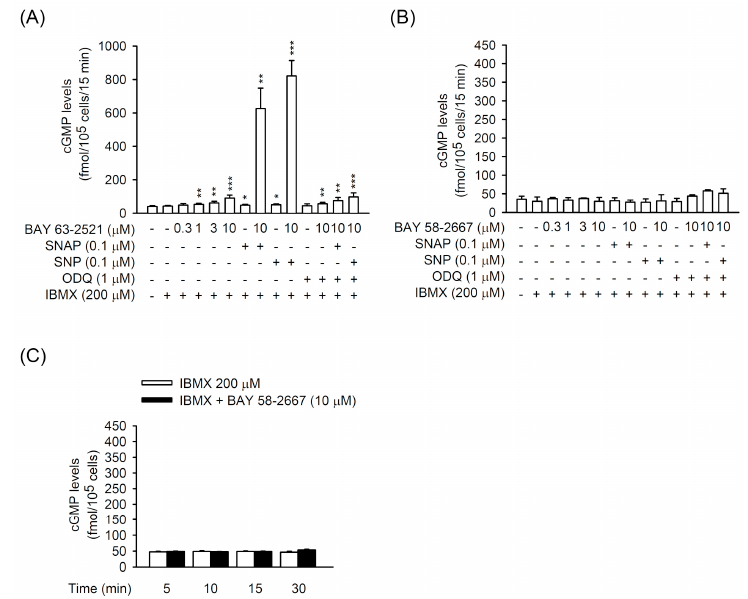
Figure 6. Effects of BAY 63-2521 and BAY 58-2667 on cGMP formation in HSCs. HSCs were Figure 6. E ff ects of BAY 63-2521 and BAY 58-2667 on cGMP formation in HSCs. HSCs were preincubated preincubated with or without IBMX (200 μ M) and/or ODQ (1 μ M) for 15 min and then treated with with or without IBMX (200 µ M) and / or ODQ (1 µ M) for 15 min and then treated with ( A ) BAY 63-2521 (0.3-10 µ M) or ( B , C ) BAY 58-2667 (0.3–10 µ M) in the presence or absence of SNAP (0.1 µ M) or SNP